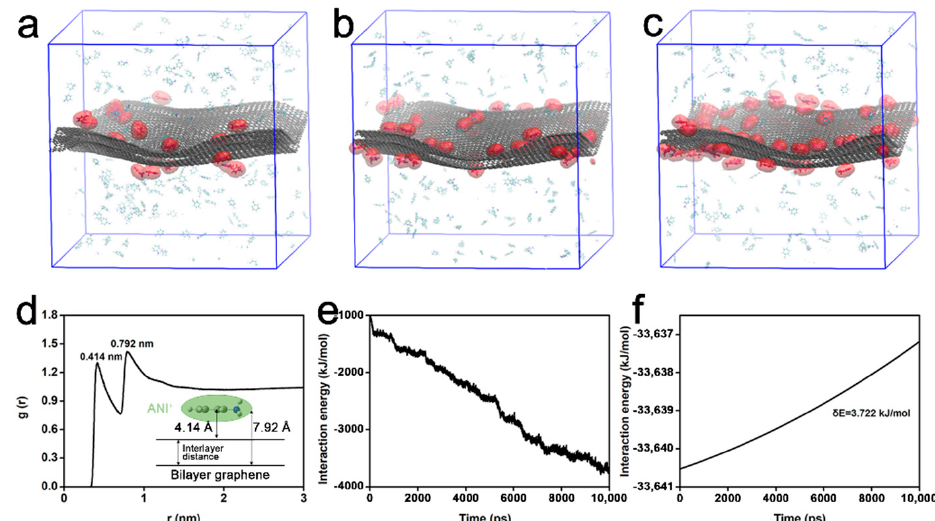
Figure 2. MD simulations of ANI + adsorbed on the surface of bilayer graphene. ( a – c ) Snapshots of the adsorption process with simulated times of ( a ) 0 ns, ( b ) 5 ns, and ( c ) 10 ns. ANI + within 0.5 nm from graphene is presented using the van der Waals surface model (red), as the others were the transparent line model. H 2 O and Cl – are hidden to facilitate observation. ( d ) Radial distribution function between the centroid of ANI + and carbon atoms in bilayer graphene, and (insert) their adsorption model. ( e , f ) van der Waals interaction energy between ( e ) ANI + and bilayer graphene, and ( f ) graphene layers in bilayer graphene.